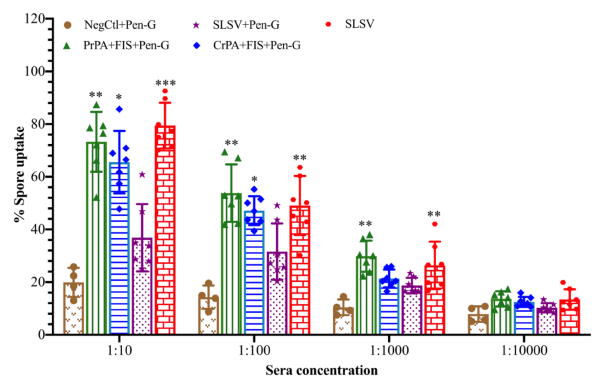
Figure 7. Bacillus anthracis 34F2 spores phagocytosis by RAW 267.7 macrophages with varying dilutions of sera from cattle groups vaccinated with PrPA + FIS + Emulsigen-D ® / Alhydrogel ® plus Pen-G, CrPA + FIS + Emulsigen-D ® / Alhydrogel ® plus Pen-G, SLSV plus Pen-G, SLSV alone groups and NegCtl groups (Emulsigen-D ® / Alhydrogel ® plus Pen-G). The mean value of spore uptake is presented in the form of bar charts with the standard deviations. The significant values between groups are presented as *** p < 0.001, ** p < 0.01, * p ≤ 0.05. Purified recombinant protective antigen: PrPA; Crude recombinant protective antigen: CrPA; Formalin inactivated Bacillus anthracis spores: FIS; Penicillin-G: Pen-G; Sterne live spore vaccine: SLSV; Negative control: NegCtl (Emulsigen-D ® / Alhydrogel ® plus Pen-G).